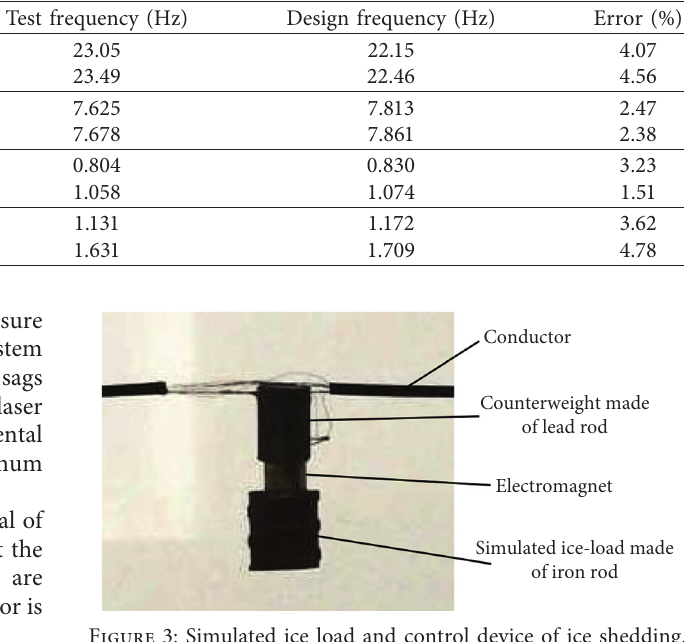
Table 3: Comparison of test frequency and design frequency.